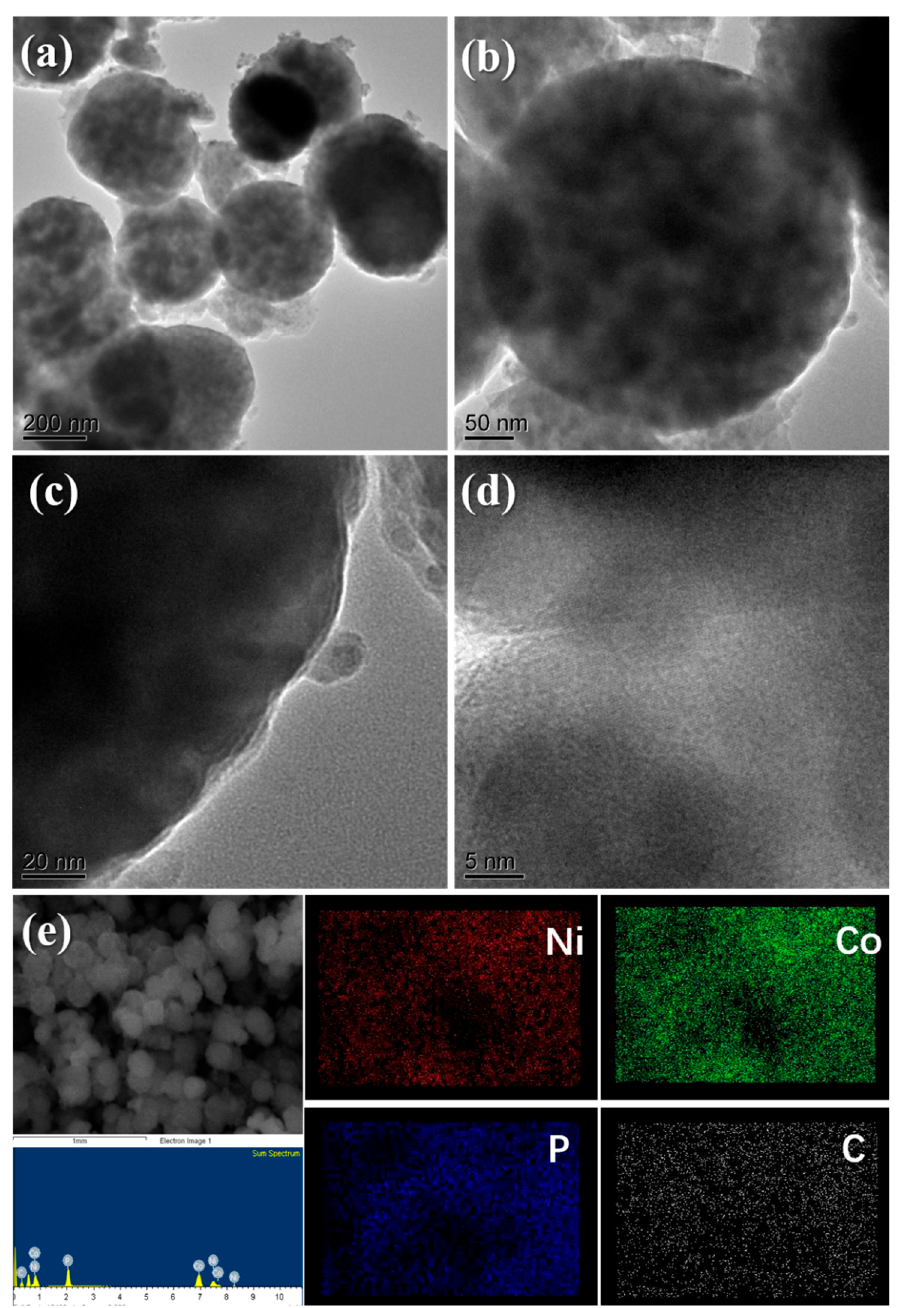
Figure 3. ( a )–( d ) TEM images of P-1:3 sample; ( e ) element mapping. Figure 3. ( a – d ) TEM images of P-1:3 sample; ( e ) element